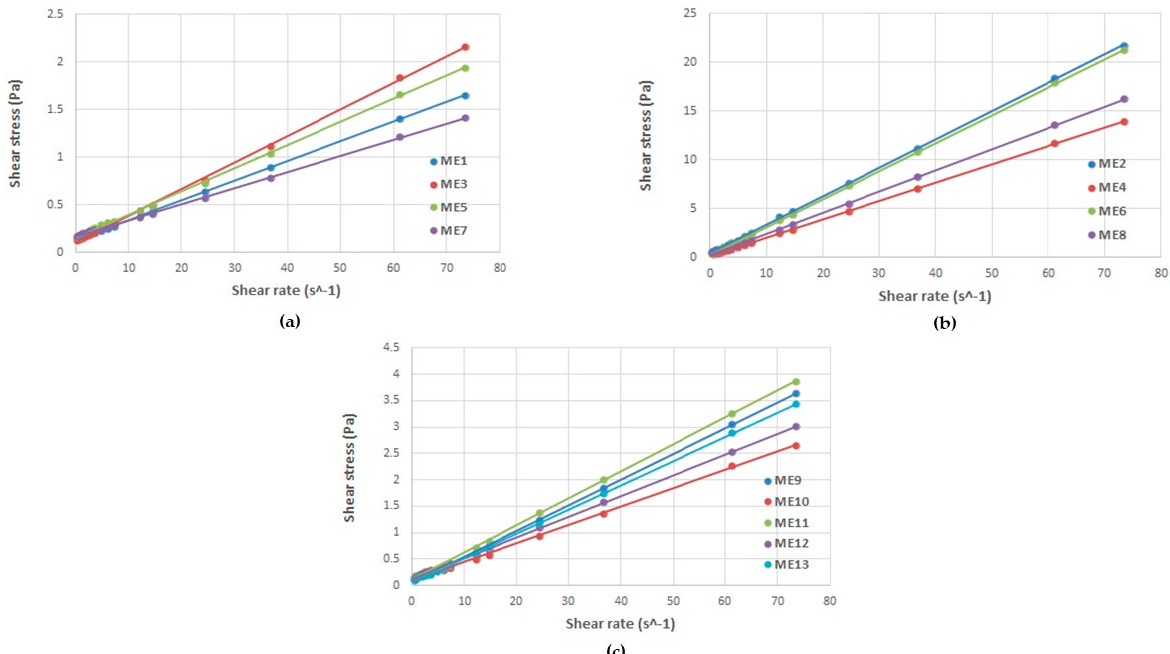
Figure 5. Rheological profiles expressed as shear stress as a function of shear rate for MELSA 1– MELSA 13 microemulsions, tested at 25 ± 0.5 °C, proving their Newtonian behavior, divided in three groups: ( a ) microemulsions with low viscosity, ( b ) microemulsions with high viscosity, and ( c ) mi- croemulsions with intermediate